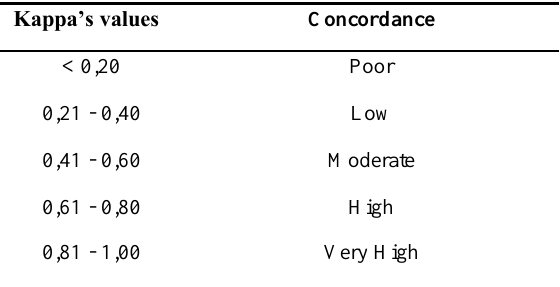
Table 1. Value to evaluate the degree of agreement from the Kappa